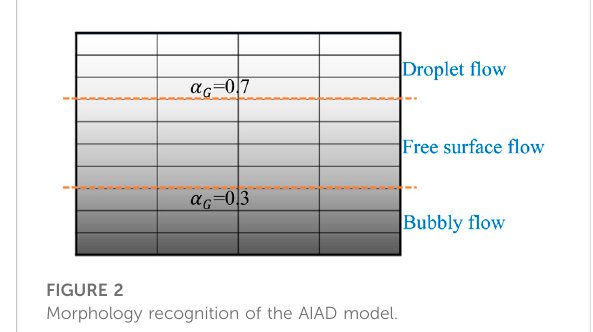
FIGURE 2 Morphology recognition of the AIAD